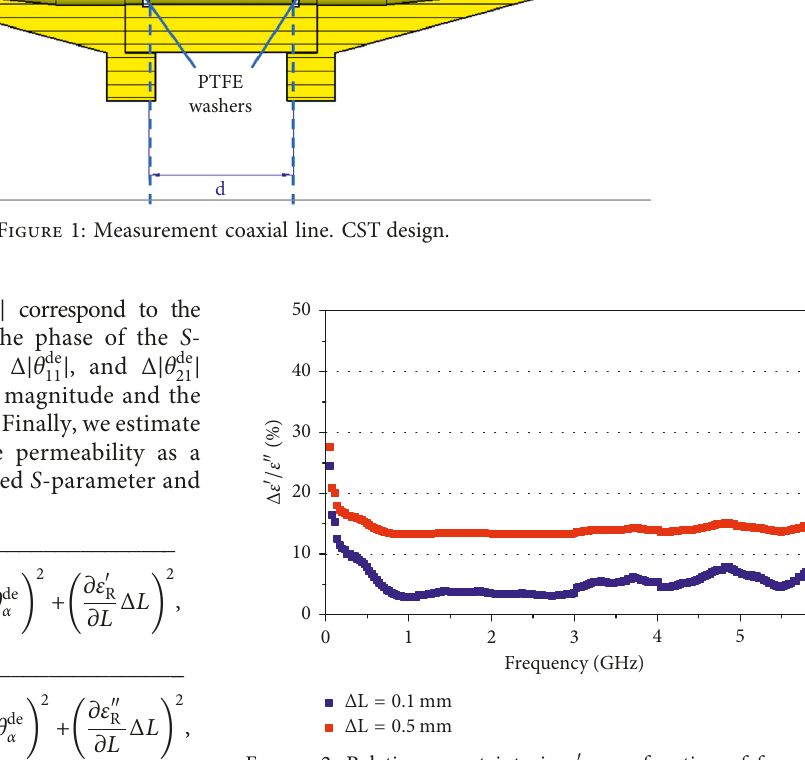
as a function of frequency R ′